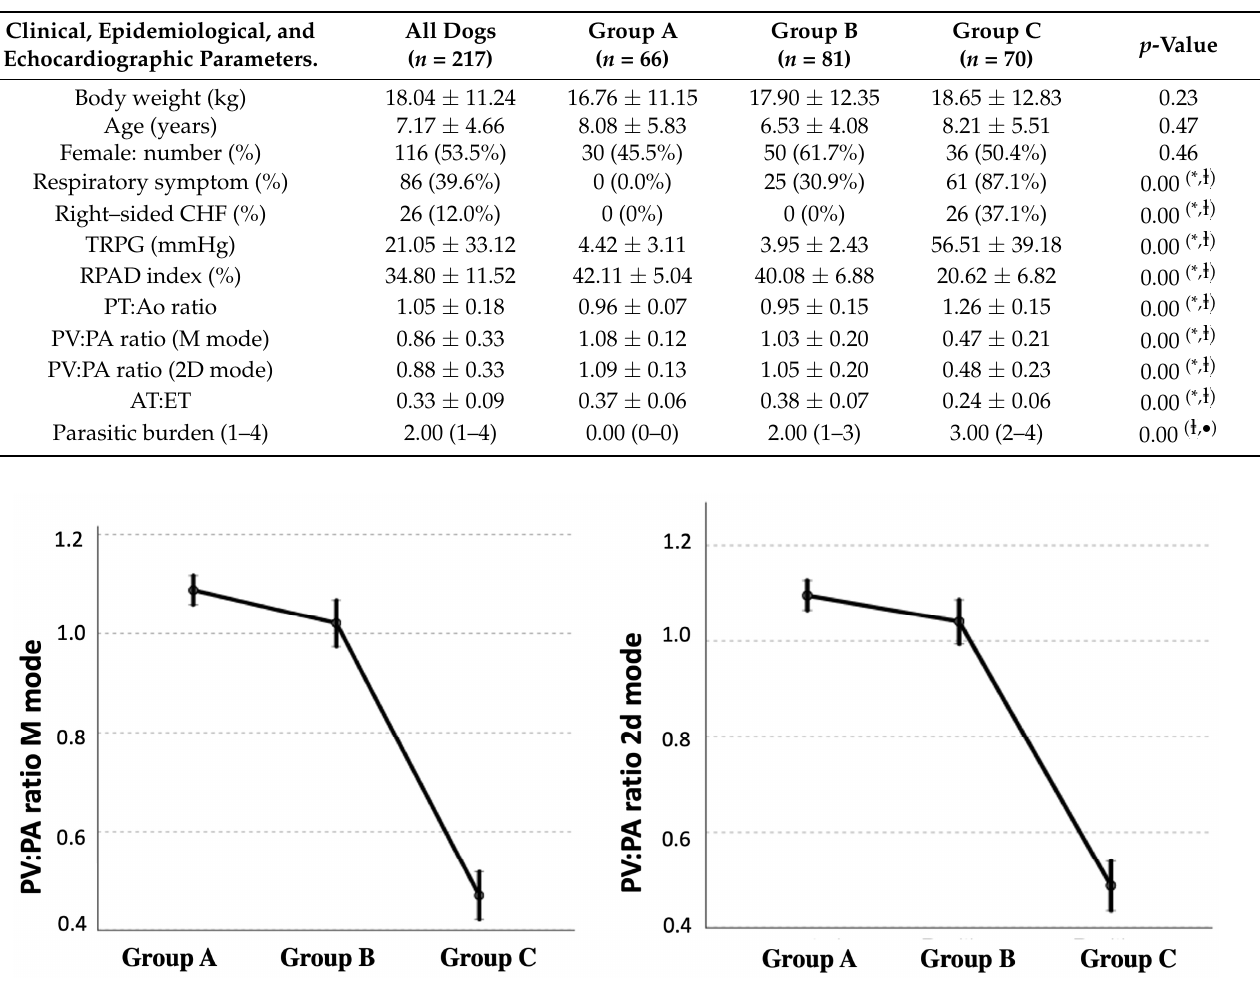
Figure 2. Scatterplots illustrating the right pulmonary vein to pulmonary artery (PV:PA) ratios in time–motion mode (M mode) and two-dimensional mode (2D mode), obtained in healthy dogs (group A), in dogs with heartworm and absence of PH (group B), and in dogs with heartworm and presence of PH (group C). The results show the estimated marginal means and their CI 95%.